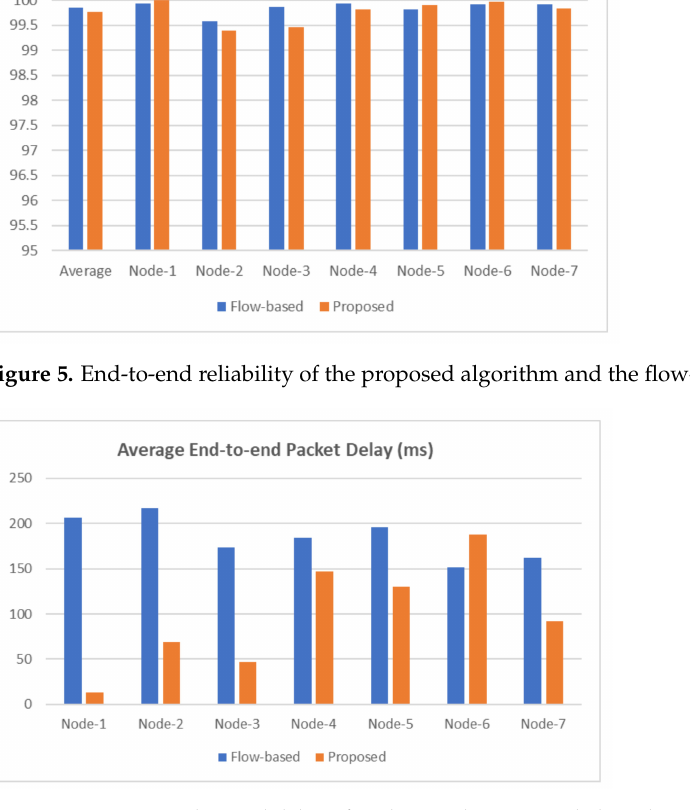
Figure 6. Average end-to-end delay of packets in the proposed algorithm and the flow-based